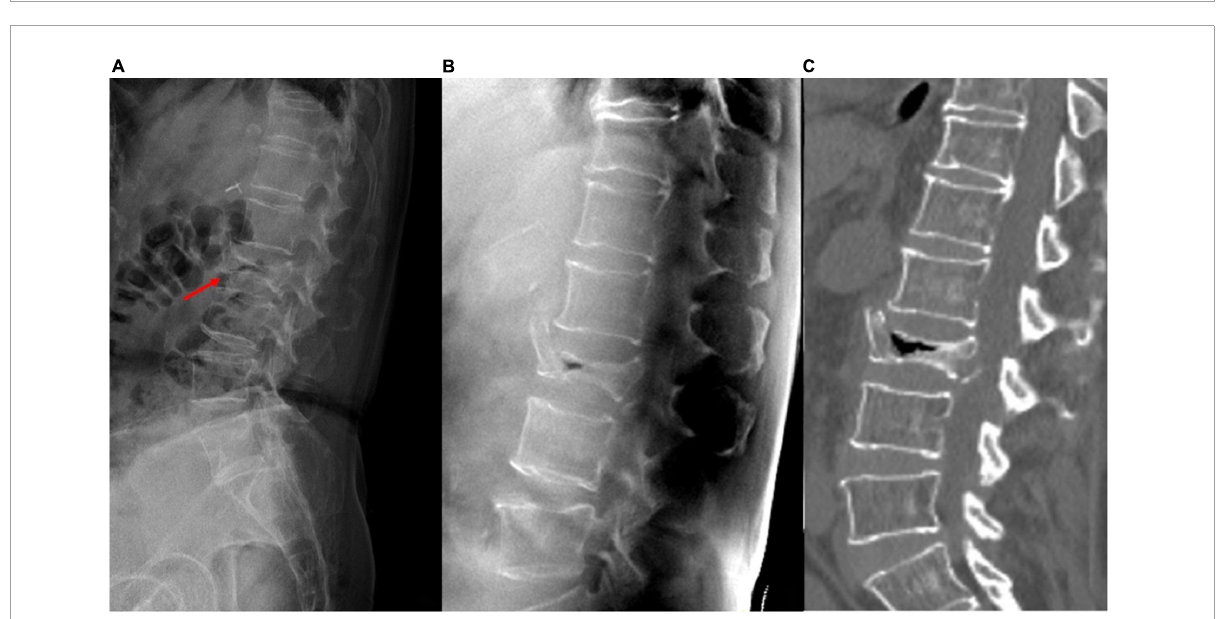
FIGURE5 A patient with acute L2 vertebral compression fracture (VCF). (A) Plain radiograph shows bowel gas superimposed on the spine, and the fracture lines of the collapsed vertebra cannot be clearly seen. (B) Tomosynthesis and (C) CT both clearly show the extent of fractures and the air-filled